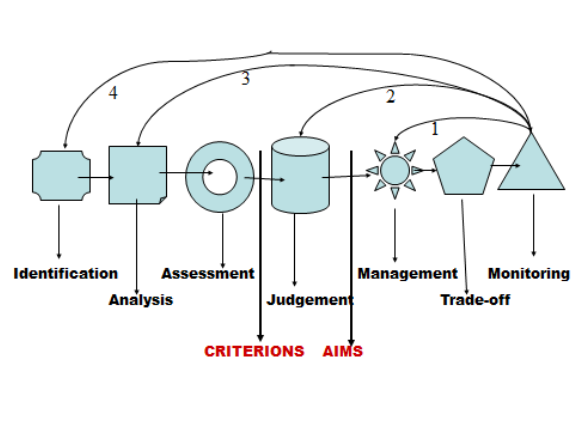
Figure 1. Flowchart for determining the risks for Figure 2. Process model of work with risks targeted to safe